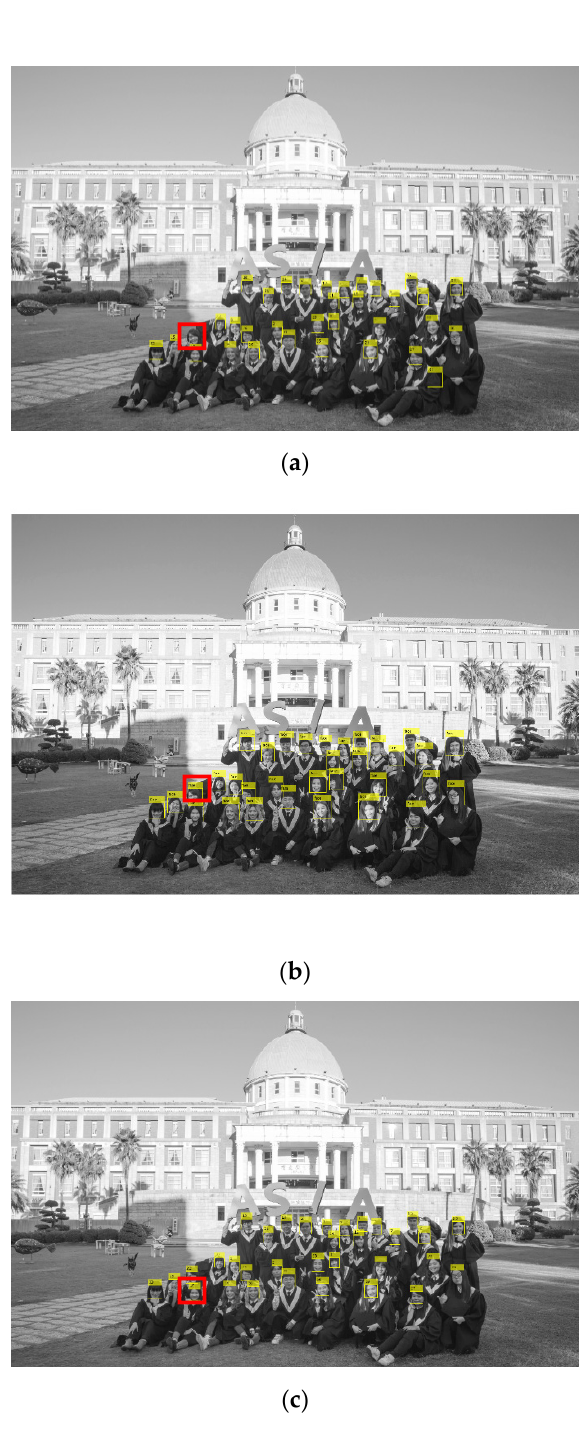
Figure 8. Comparisons of people calculating results: ( a ) using the VJ algorithm with merging threshold = 5; ( b ) using the YOLOv4 network; ( c ) using the proposed method. Table 4. System comparisons among the VJ algorithm, YOLOv4 network, and the proposed app.